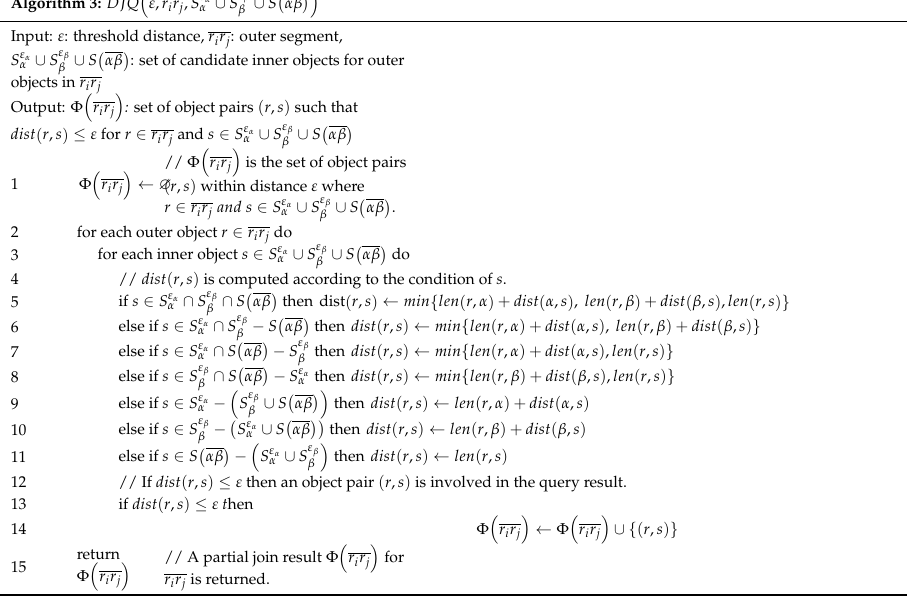
(cid:16) ε , r i r j , S ε α α ∪ S ε β β ∪ S (cid:0) αβ